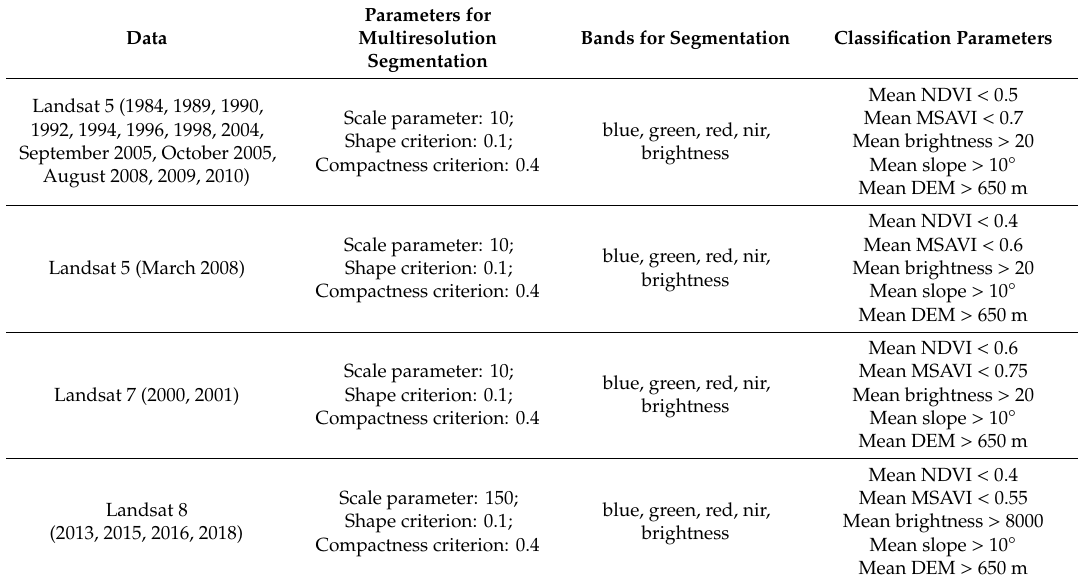
Table 4. Segmentation and classification parameters used for object-based landslide